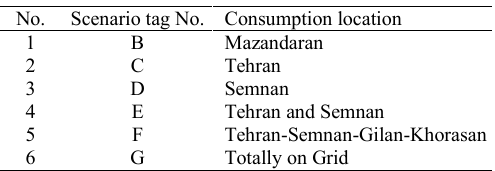
Totally on Grid Table 5: Degradation scenarios description Plant type and degradation power factor Table 6: First group of scenarios investigating plant type, fuel type, fuel transfer means on carbon footprint Scenarios